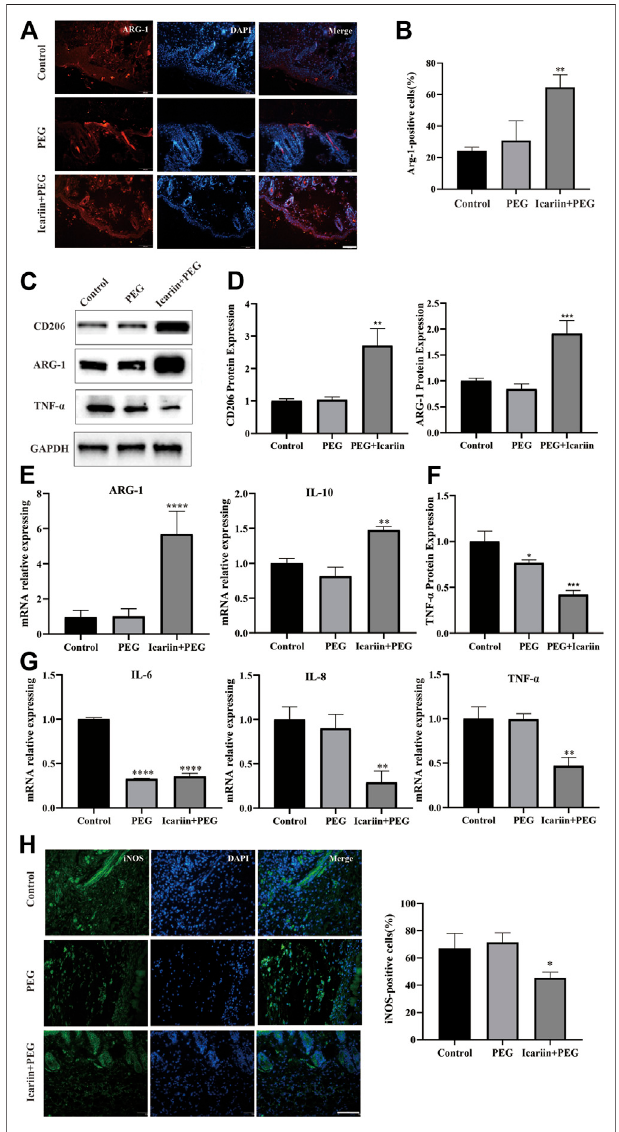
FIGURE 4 | Icariin+PEG hydrogel promoted macrophage M2 polarization and reduced in fl ammation in the early stage of wound healing in vivo . (A) Representativeimmuno fl uorescencepicturesofARG1expressionon day7attheinjuredsites.Scalebar:100 μ m. (B) Quanti fi cationofARG1- positive cells in different groups. (C,D) Protein expression level of CD206 and ARG1 as detected by western blotting on day 7 at injured sites. Quanti fi cation of the western blotting bands compared to that of the control group. (E) Expression levels of M2-related genes ARG1 and IL-10 of the three groups by RT-PCR. (F) ProteinexpressionlevelofTNF- α asdetectedbywesternblotting on day 7 at the injured sites. Quanti fi cation of the western blotting bands compared to that of the control group. (G) Expression level of in fl ammation- related genes IL-6, IL-8, and TNF- α in different groups by RT-PCR. (H) Representative immuno fl uorescence pictures of iNOS expression on day 7 at injured sites. Scale bar: 100 μ m. Quanti fi cation of iNOS-positive cells in different